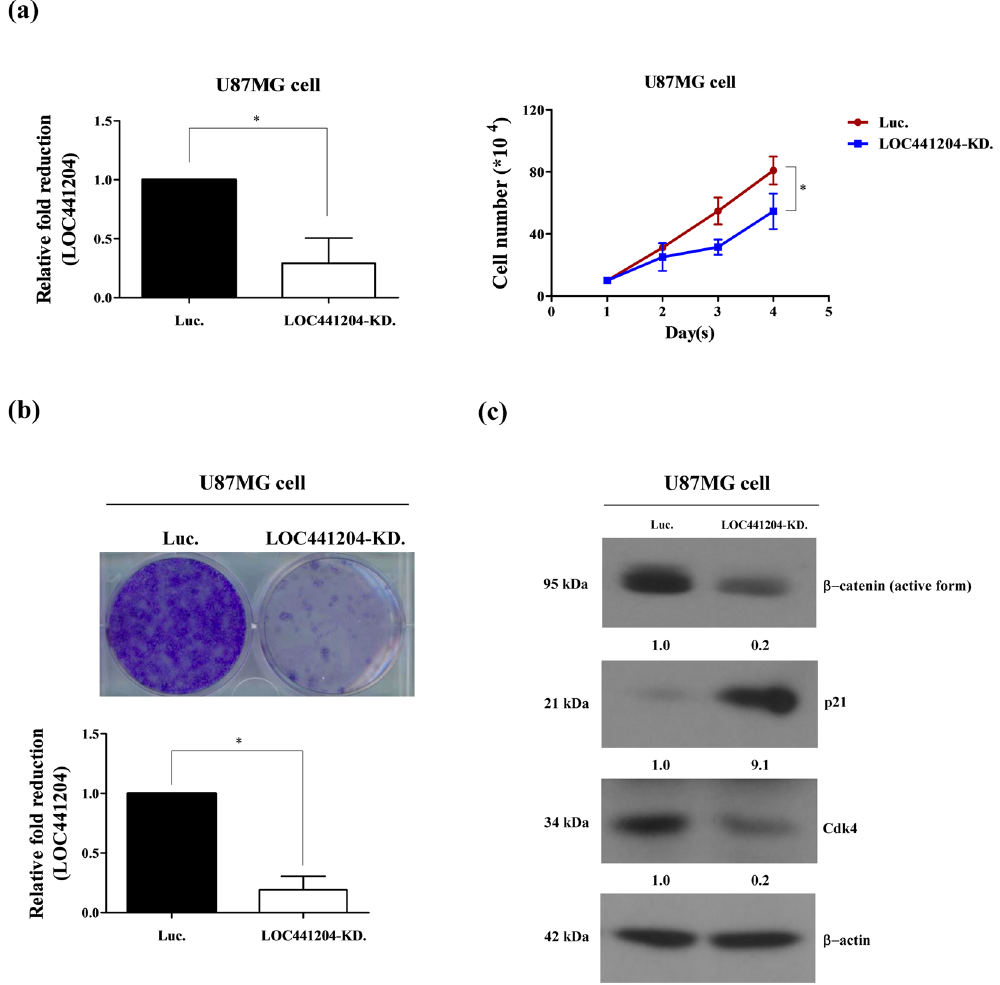
Figure 3. LOC441204 depletion suppresses U87MG cell proliferation. ( a ) Right panel : The cell growth ability of U87MG was analyzed under LOC441204-depleted (LOC441204 KD) and control (Luc) conditions. Left panel : Quantification of LOC441204 expression. ( b ) Colony assay of U87MG under similar conditions. ( c ) Western blot analysis of β -catenin, p21 and cdk4 expression levels in cell lines. Differences were analyzed using the Kruskal–Wallis test ( * P <